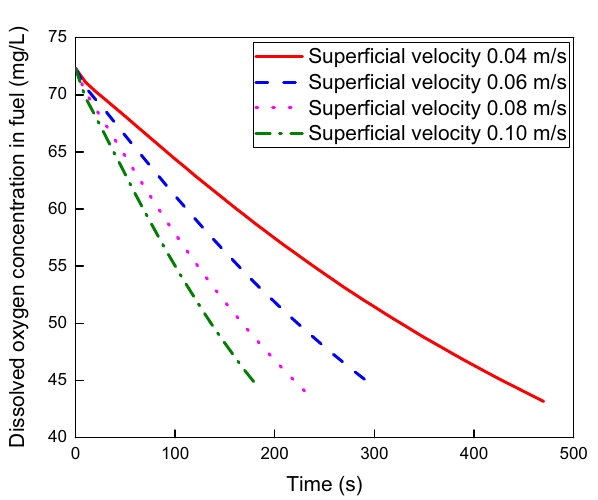
Figure 8. Oxygen volumetric mass transfer coefficient at different bubble diameters.